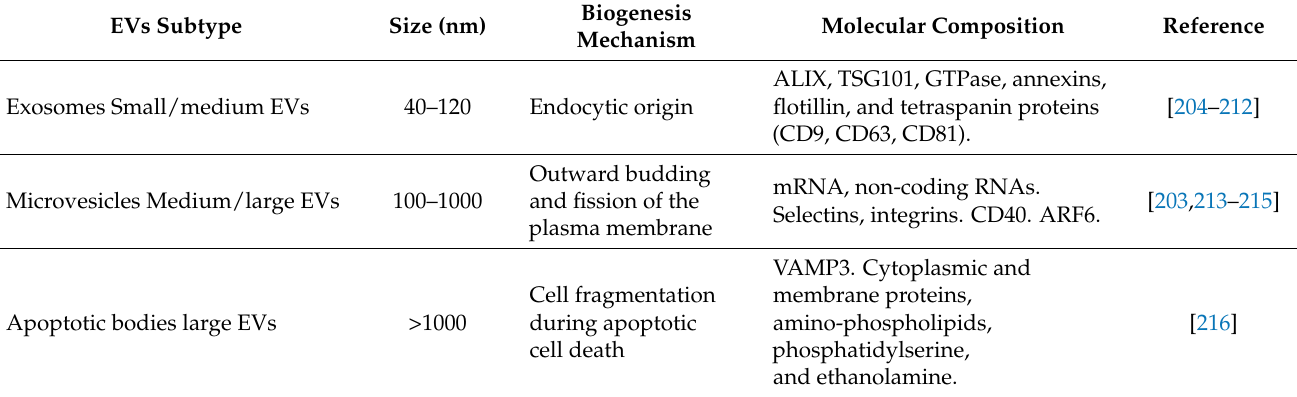
Table 3. Main characteristics of